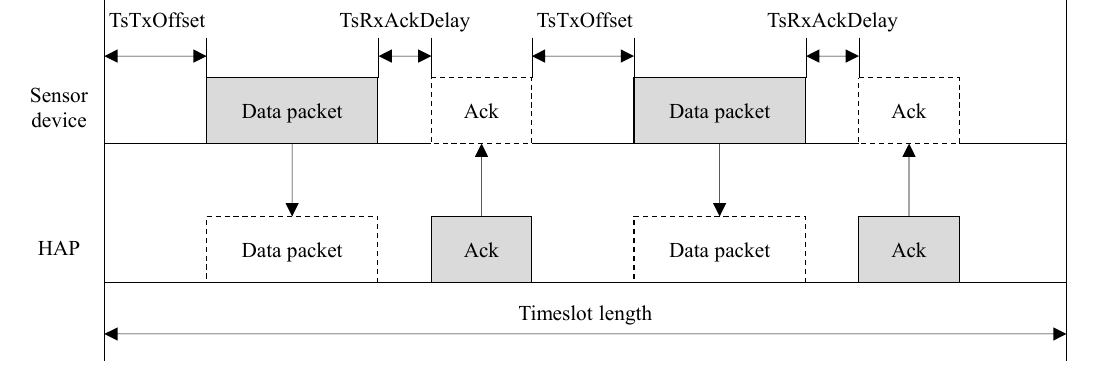
Figure 5. Timing diagram for a timeslot.